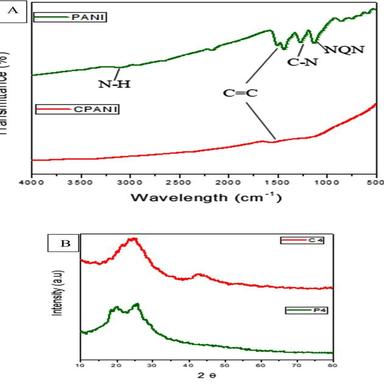
FT-IR spectra of (a) Nano-PANI and C-PANI and (b) XRD patterns of PANI (P4) and C-PANI (C4).